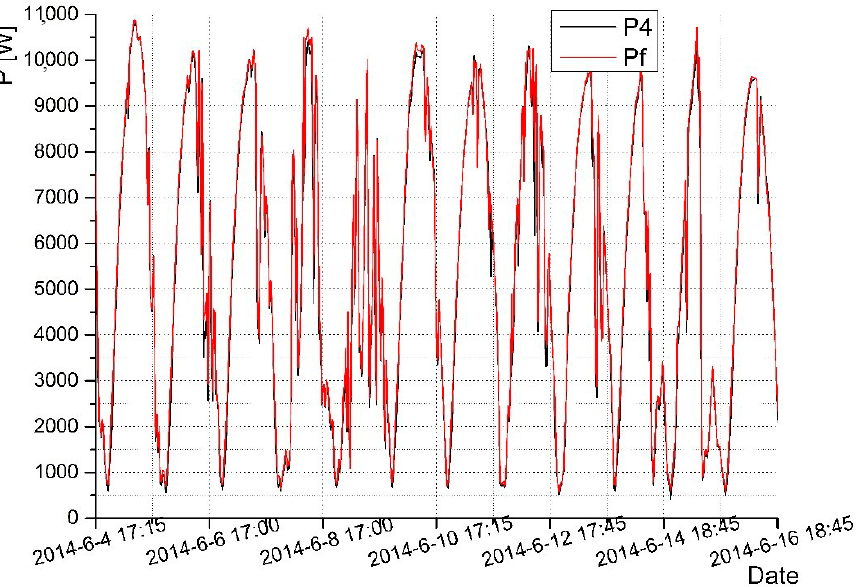
Figure 2. Comparison between the measured AC power values at inv4 and the simulated values during several days in mid-June. Table 3. Statistical metrics of the inverter 4 of PVS1 for the period 5 June 2014 to 17 June 2014 (normal operation).